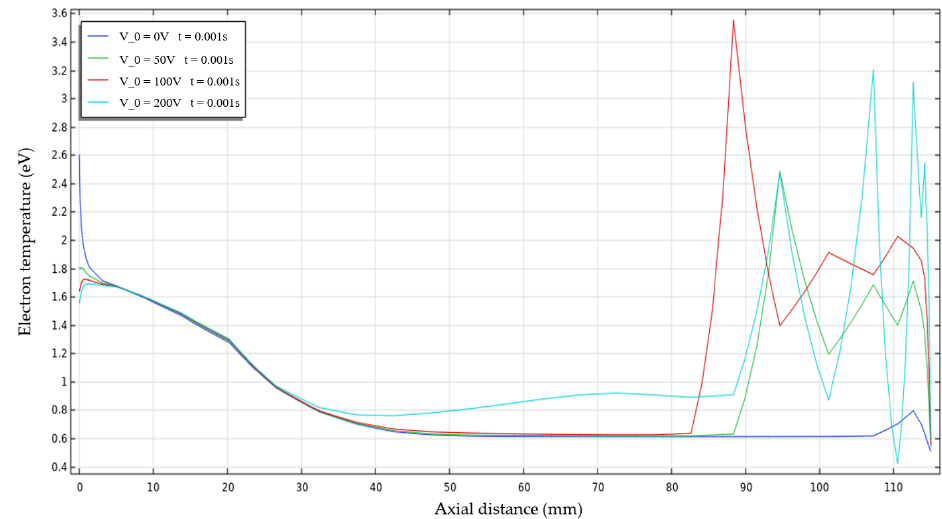
Figure 8. Axial Electron average temperature.